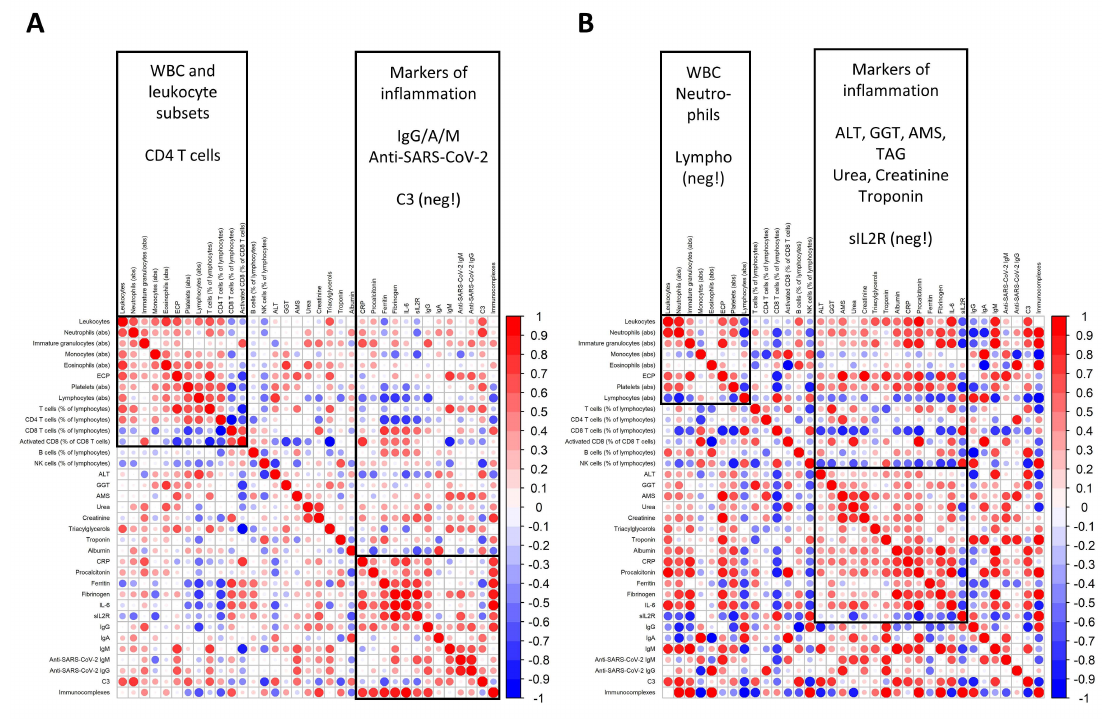
Figure 5. Discoordination of the immune response. ( A ) Heatmap showing the Spearman correlation coe ffi cients between selected parameters mapping the inflammation, immune response, and metabolic parameters in patients with a mild course of the disease. ( B ) Heatmap showing the Spearman correlation coe ffi cients between selected parameters mapping the inflammation, immune response, and metabolic parameters in patients with a fatal course of the disease. The size and opacity of the individual circles represent the Spearman correlation R-value between each pair of variables. A positive correlation is shown in shades of red, and a negative correlation in shades of blue. No sorting algorithm was used; parameters were ordered manually based on thematic groups. WBC: white blood cell, TAG: